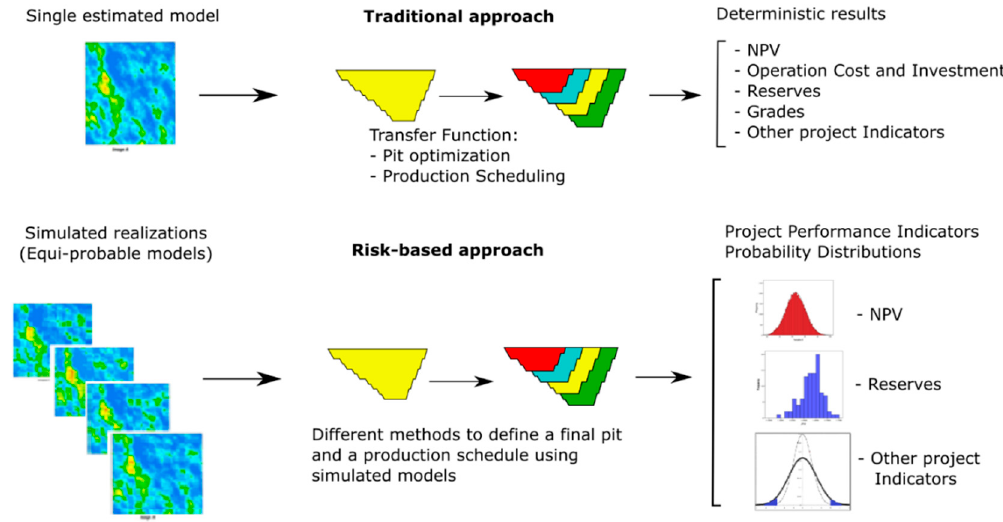
Figure 2. Traditional and risk-based approaches applied in mine planning (adapted with permission from [5]).